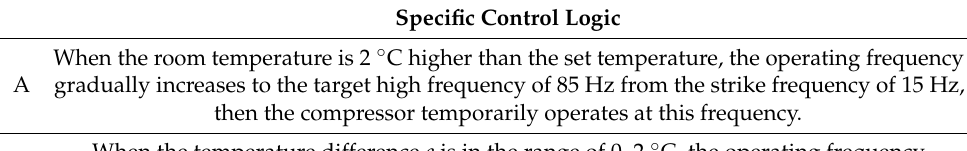
Specific Control